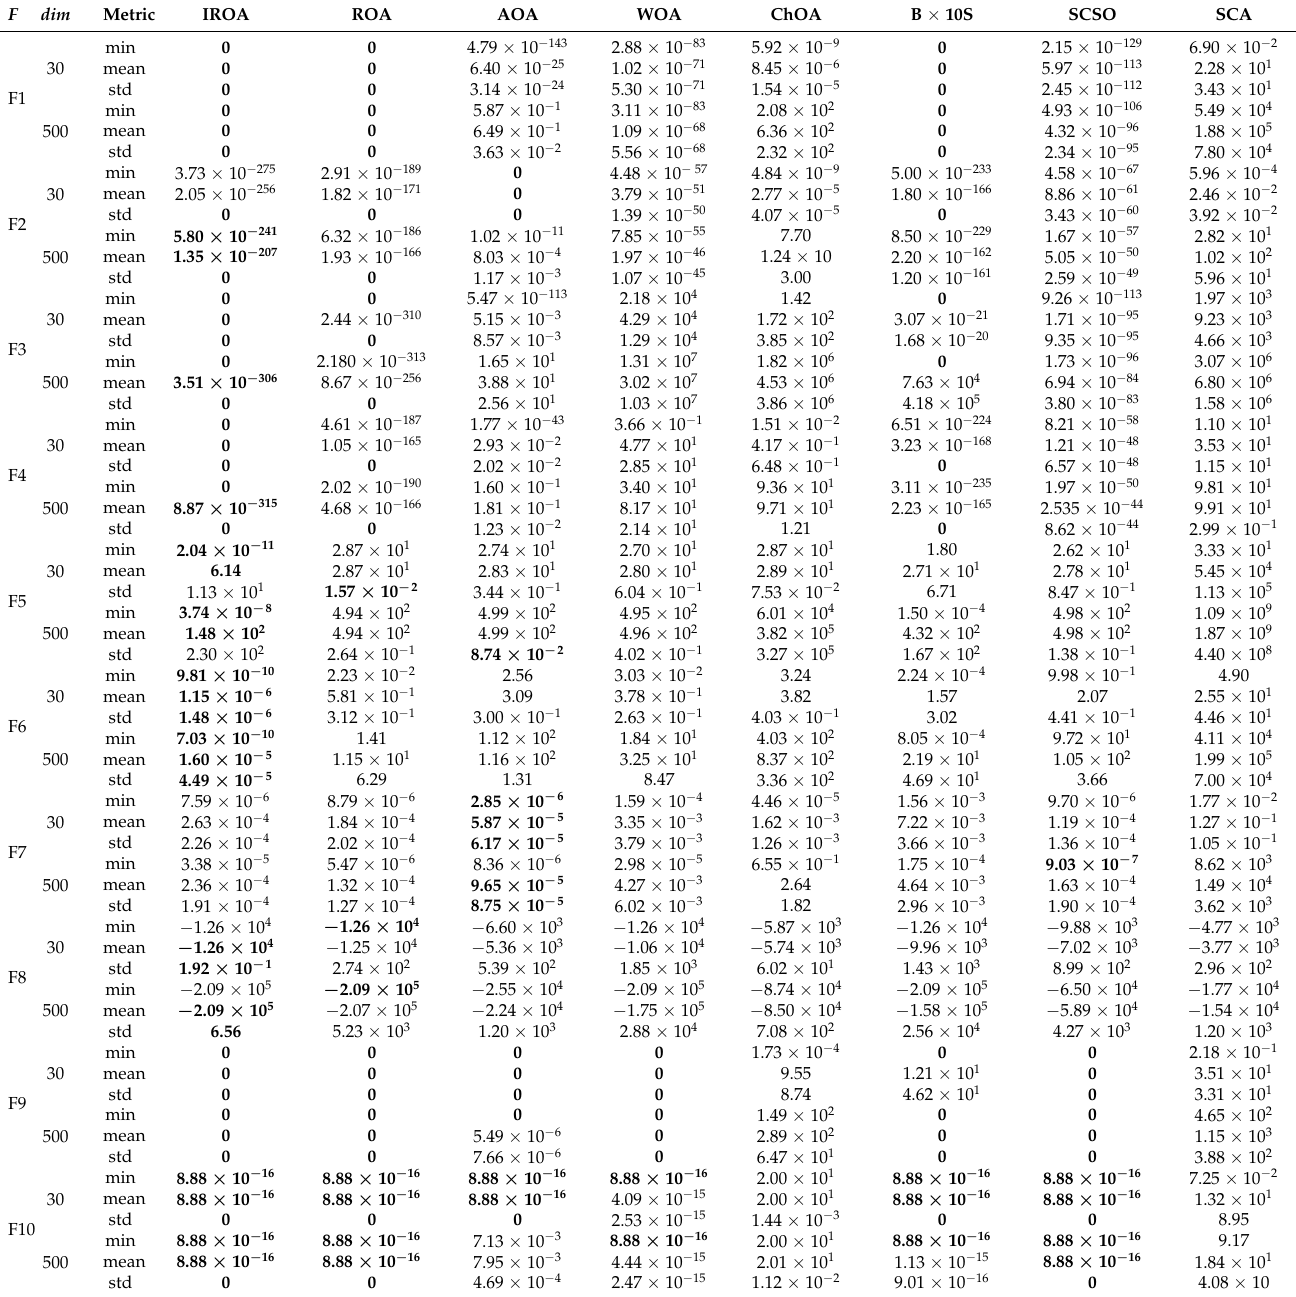
Table 3. Statistical results of 23 standard reference